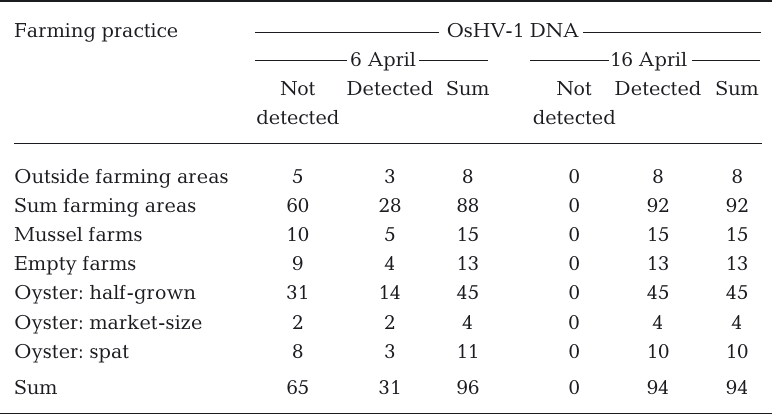
DNA frequency and quantity, or energetic reserves of the sentinel oysters. Table 2. Detection of Ostreid herpesvirus 1 (OsHV-1) DNA according to farming practice and time in oysters Crassostrea gigas deployed in the Thau lagoon. Data are the number of pearlnets containing the sampled oysters (n = 10 pooled animals for each